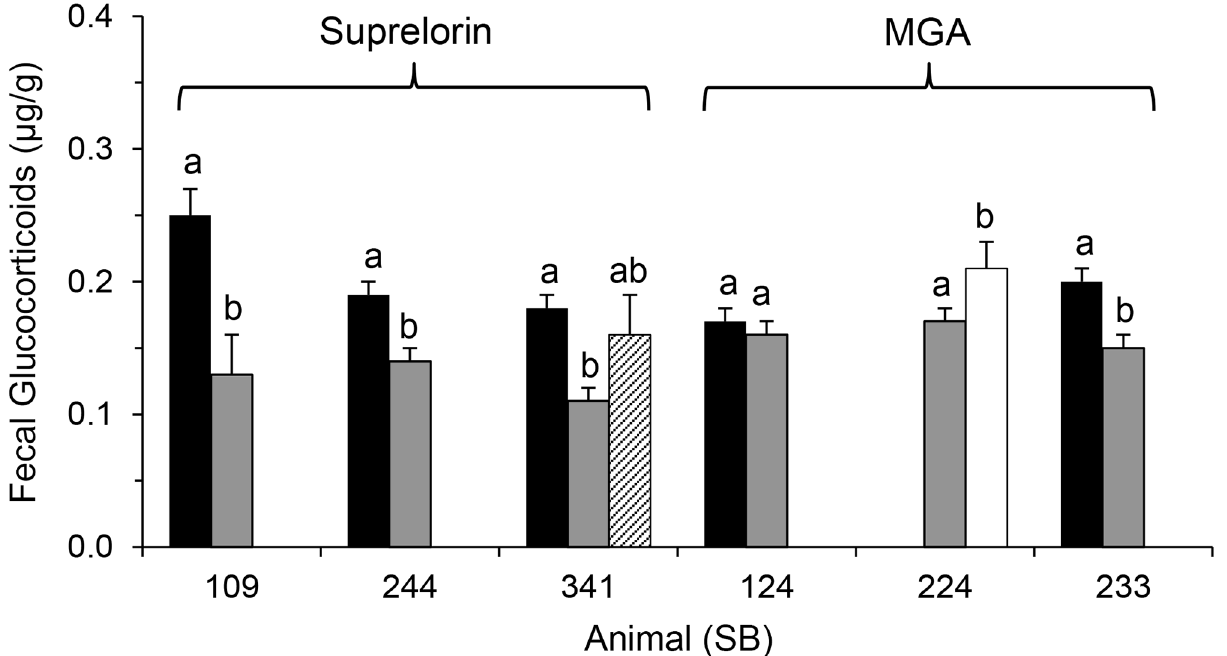
Fig 7. Comparison of mean FGM concentrations ( μ g/g ± SE) before birth control implant placement (black bars), on birth control treatment (grey bars), after expiration of GnRH-agonist (striped bar) and after removal of progestin (white bar) contraception implants. Within individual, different letters denotes significance ( P < 0.05).